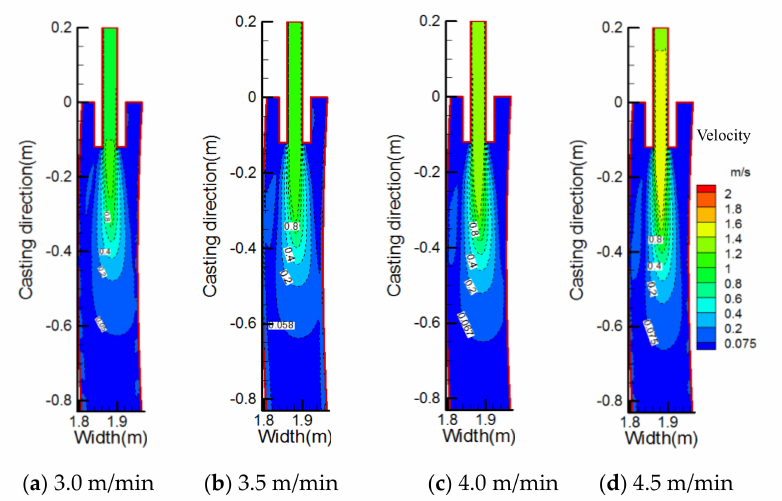
Figure 8. The velocity field of molten steel on the central symmetry plane of mold at different casting